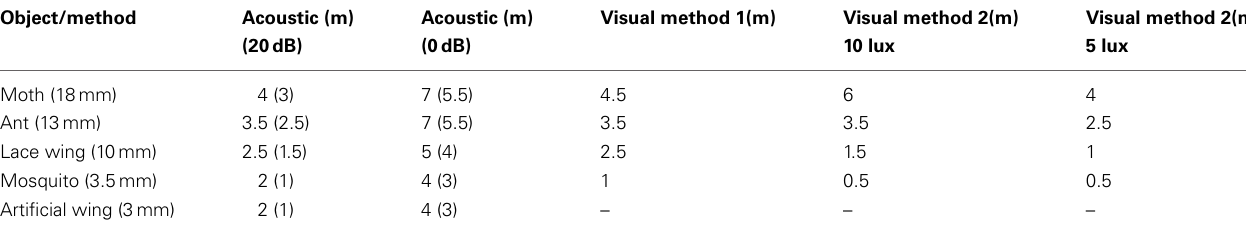
Table 1 | Echolocation and visual detection range for P. kuhlii.